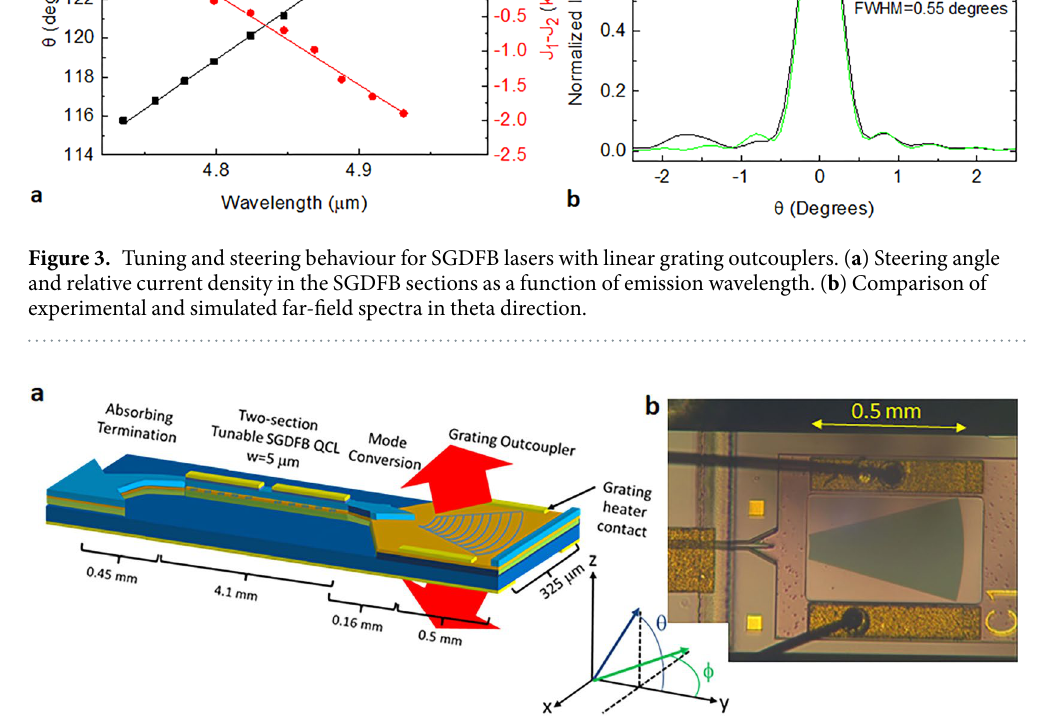
Figure 4. Monolithic mid-infrared beam steering architecture with tapered grating. ( a ) Schematic of SGDFB laser integrated with tapered grating outcoupler. ( b ) Optical microscope image waveguide taper, tapered grating outcoupler, and grating heater contract